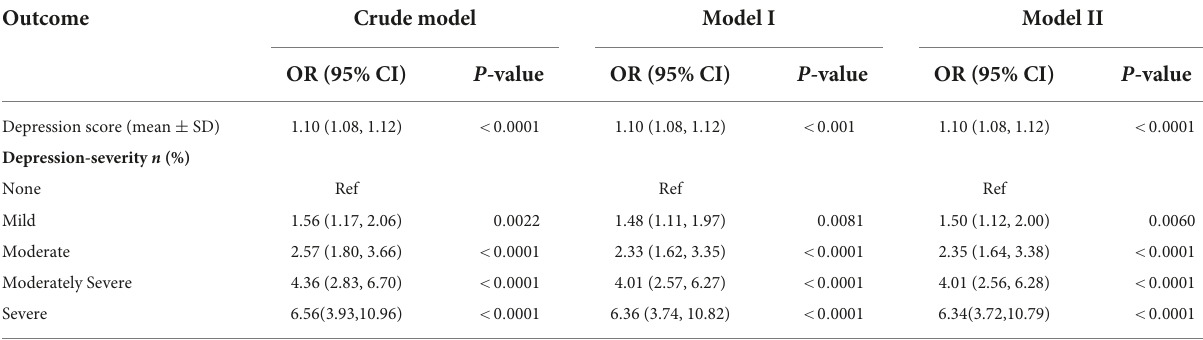
TABLE 3 Relationship between depression severity and prevalence of pelvic inflammatory diseases.